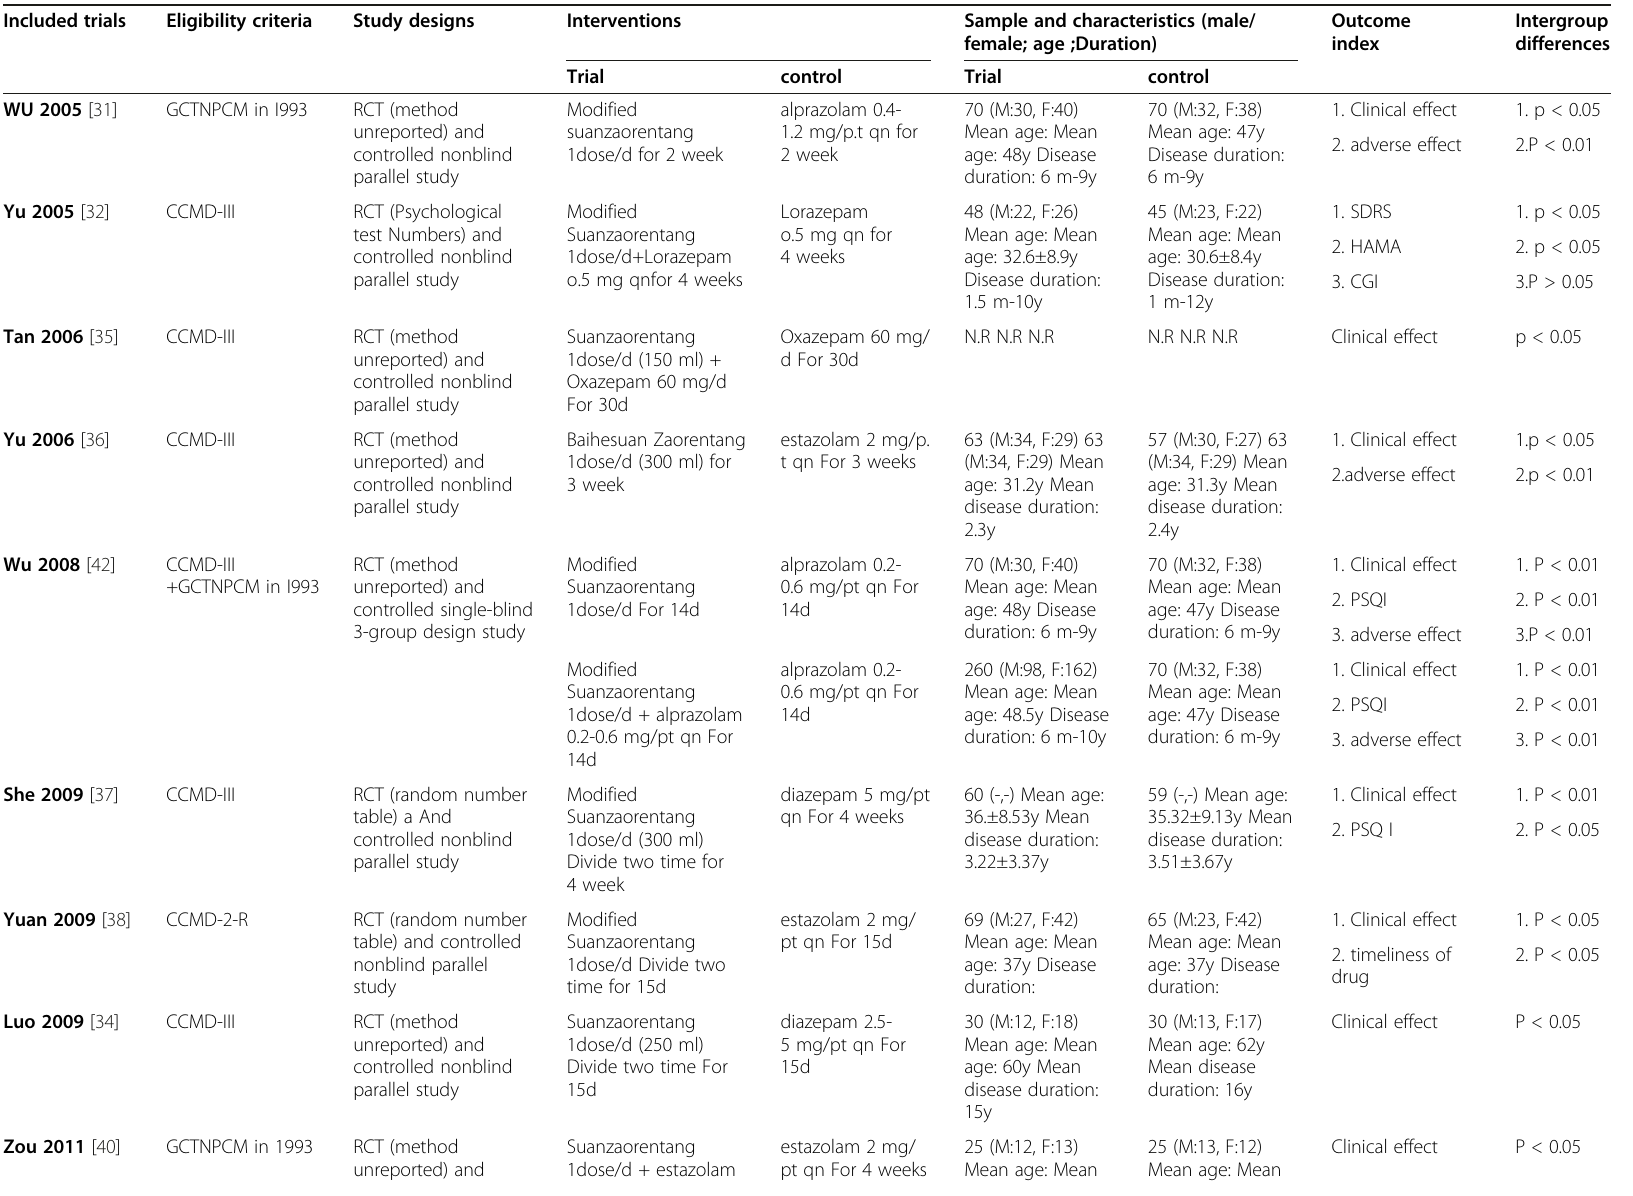
Table 1 Basic characteristics of the included studies Included